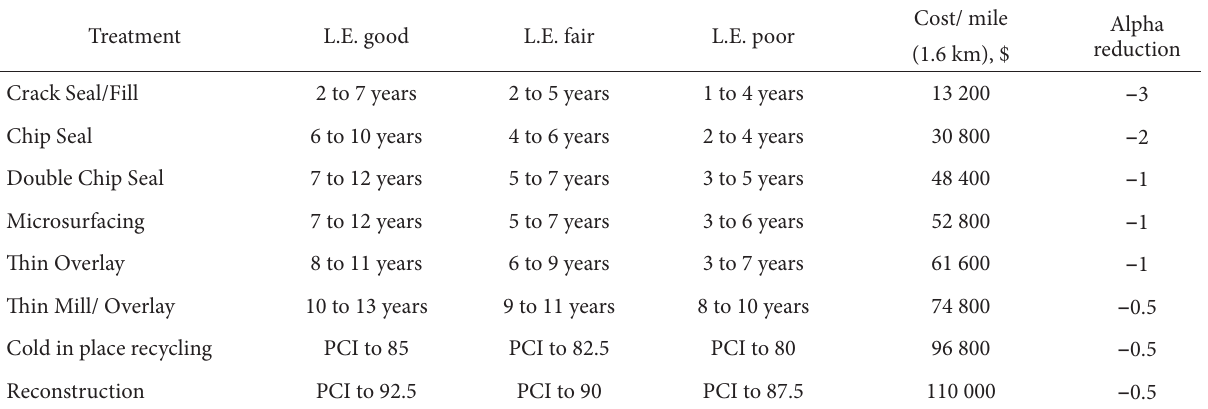
Table 3. Pavement treatments with associated costs